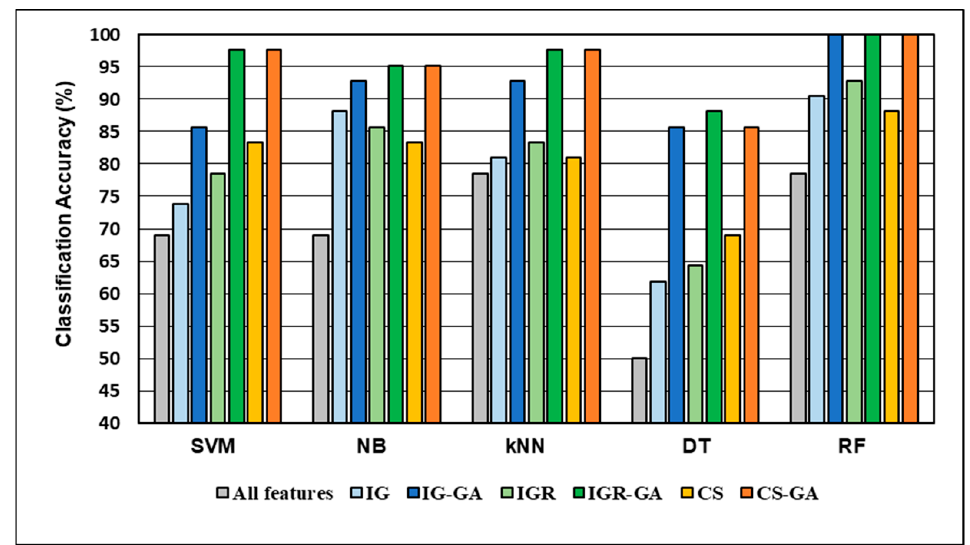
Figure 2. The accuracy comparison of classifiers using all features, the features selected only by filters methods, and the features selected by the proposed hybrid filter-GA methods on the Brain dataset.